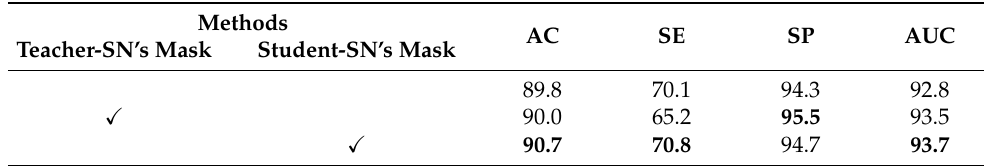
Figure 8. Comparison of the CAMs obtained by disease-CN with or without using the lesion masks: ( a ) dermoscopy images, ( b ) CAMs obtained when not using lesion masks, ( c ) CAMs obtained when using lesion masks, and ( d ) ground truth. Table 6. Comparison of average classification performance with or without masks. The highest results are shown in bold font for easy observation and